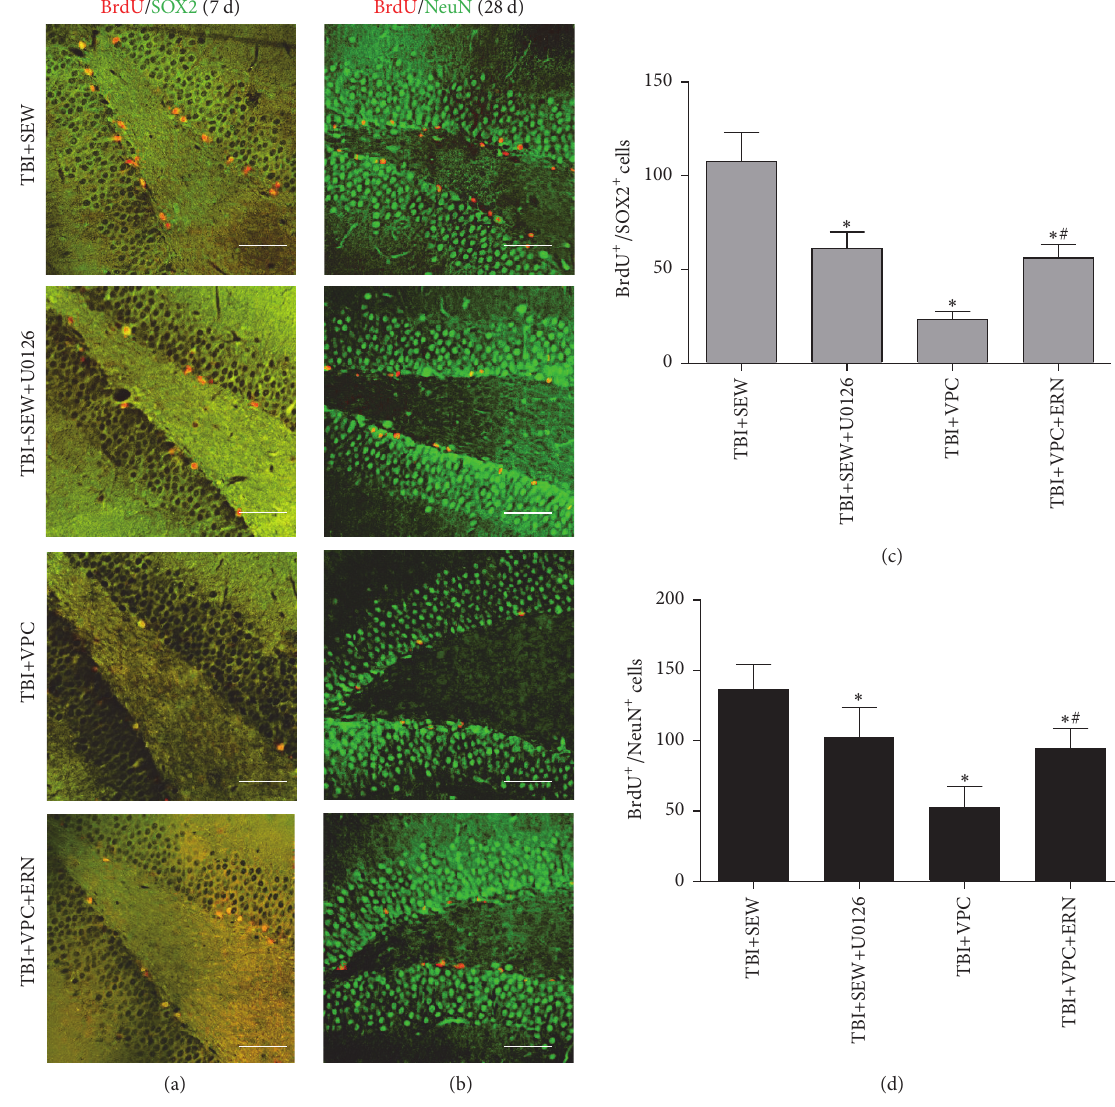
Figure 5: S1PR1-induced NSCs proliferation and neuronal differentiation in TBI rats were affected by MEK/Erk activity. (a, b) Representative IF microphotographs of hippocampus immunolabeled with BrdU/SOX2 and BrdU/NeuN in TBI+SEW, TBI+SEW+U0126, TBI+VPC, and TBI+VPC+ERN groups at 7 days and 28 days after trauma ( 𝑛 = 6 in each group). (c, d) Statistical analysis showed that, compared to TBI+SEW group, administration of U0126 significantly decreased the number of BrdU+/SOX2+ cells and BrdU+/NeuN+ cells in TBI+SEW+U0126 group. Reversely, the double-labeled cells in TBI+VPC+ERN group were significantly increased compared with TBI+VPC group. Scale bar: 50 𝜇 m. ∗ 𝑃 < 0.05 versus TBI+SEW group; # 𝑃 < 0.05 versus TBI+VPC